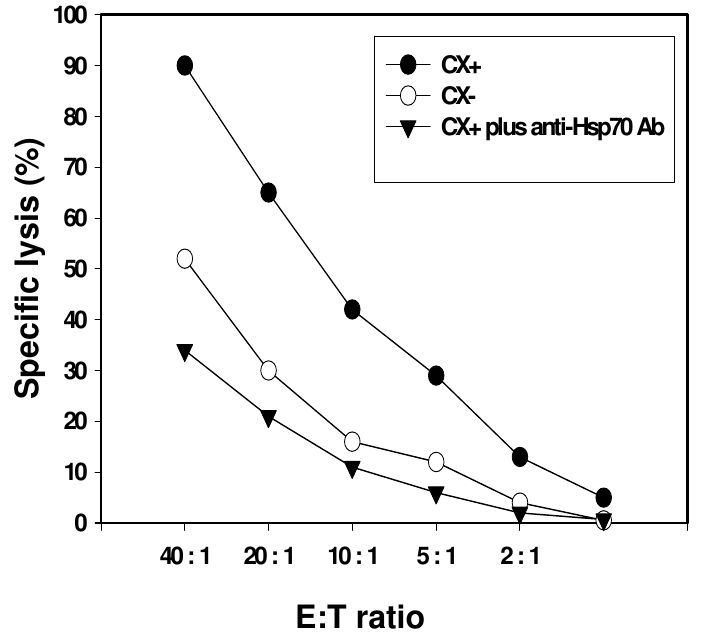
Fig. 2 Selective kill of Hsp70 membrane-positive CX+ tumor cells, mediated by NK cells, is blockable by an Hsp70-specific monoclonal antibody recognizing the Hsp70 peptide sequence